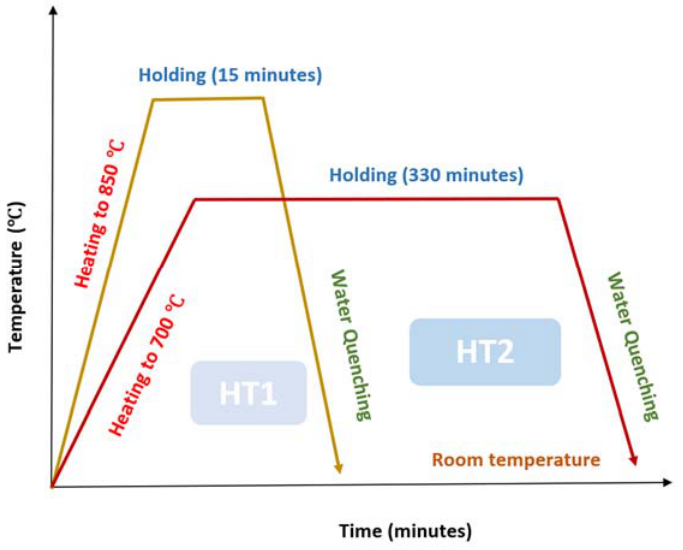
Figure 2. Schematic diagram of heat ‐ treatment procedures.